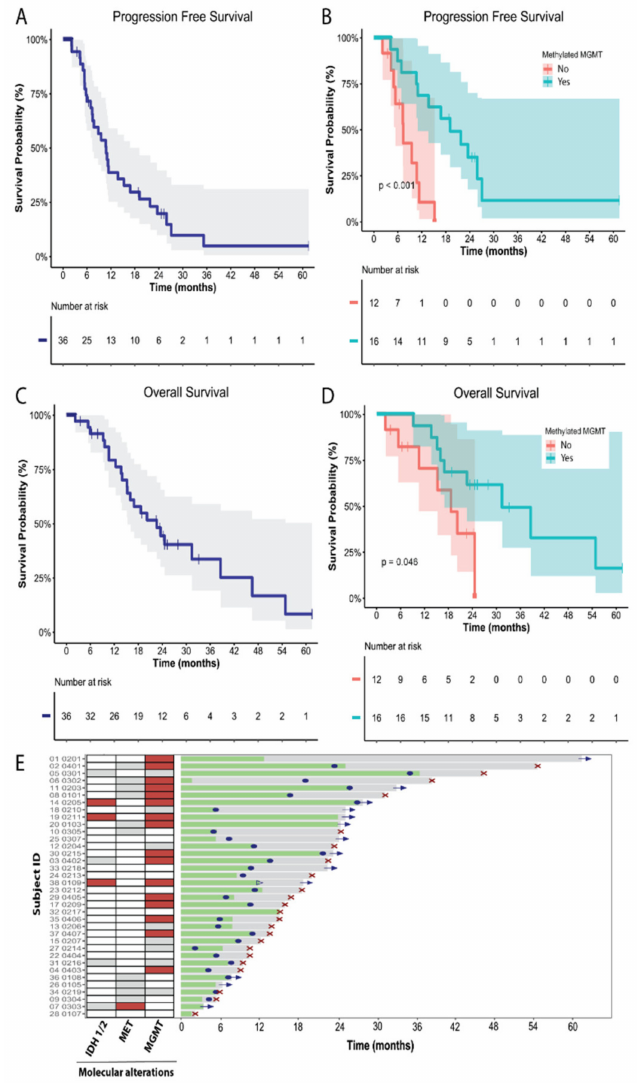
Figure 2. Crizotinib activity in the evaluable population for efficacy ( n = 36 patients). ( A ) Progression- free survival (PFS) estimated by Kaplan–Meier. ( B ) PFS estimated by Kaplan–Meier stratified by the MGMT promoter methylation status. ( C ) Overall survival (OS) estimated by Kaplan–Meier. ( D ) OS estimated by Kaplan–Meier stratified by the MGMT promoter methylation status. ( E ) Swimmer plot showing the clinical evolution of each patient. Treatment period (green), follow-up (gray), progression disease (blue dot), exitus (red cross), and patient censored (blue arrow). Patients with presence of molecular alterations (IDH1/2 mutations, MET alterations, or MGMT methylation) are highlighted in red squares in the left panel. White squares indicate presence of WT or native genes. Gray squares on the left panel represent those patients that were not analyzed or not